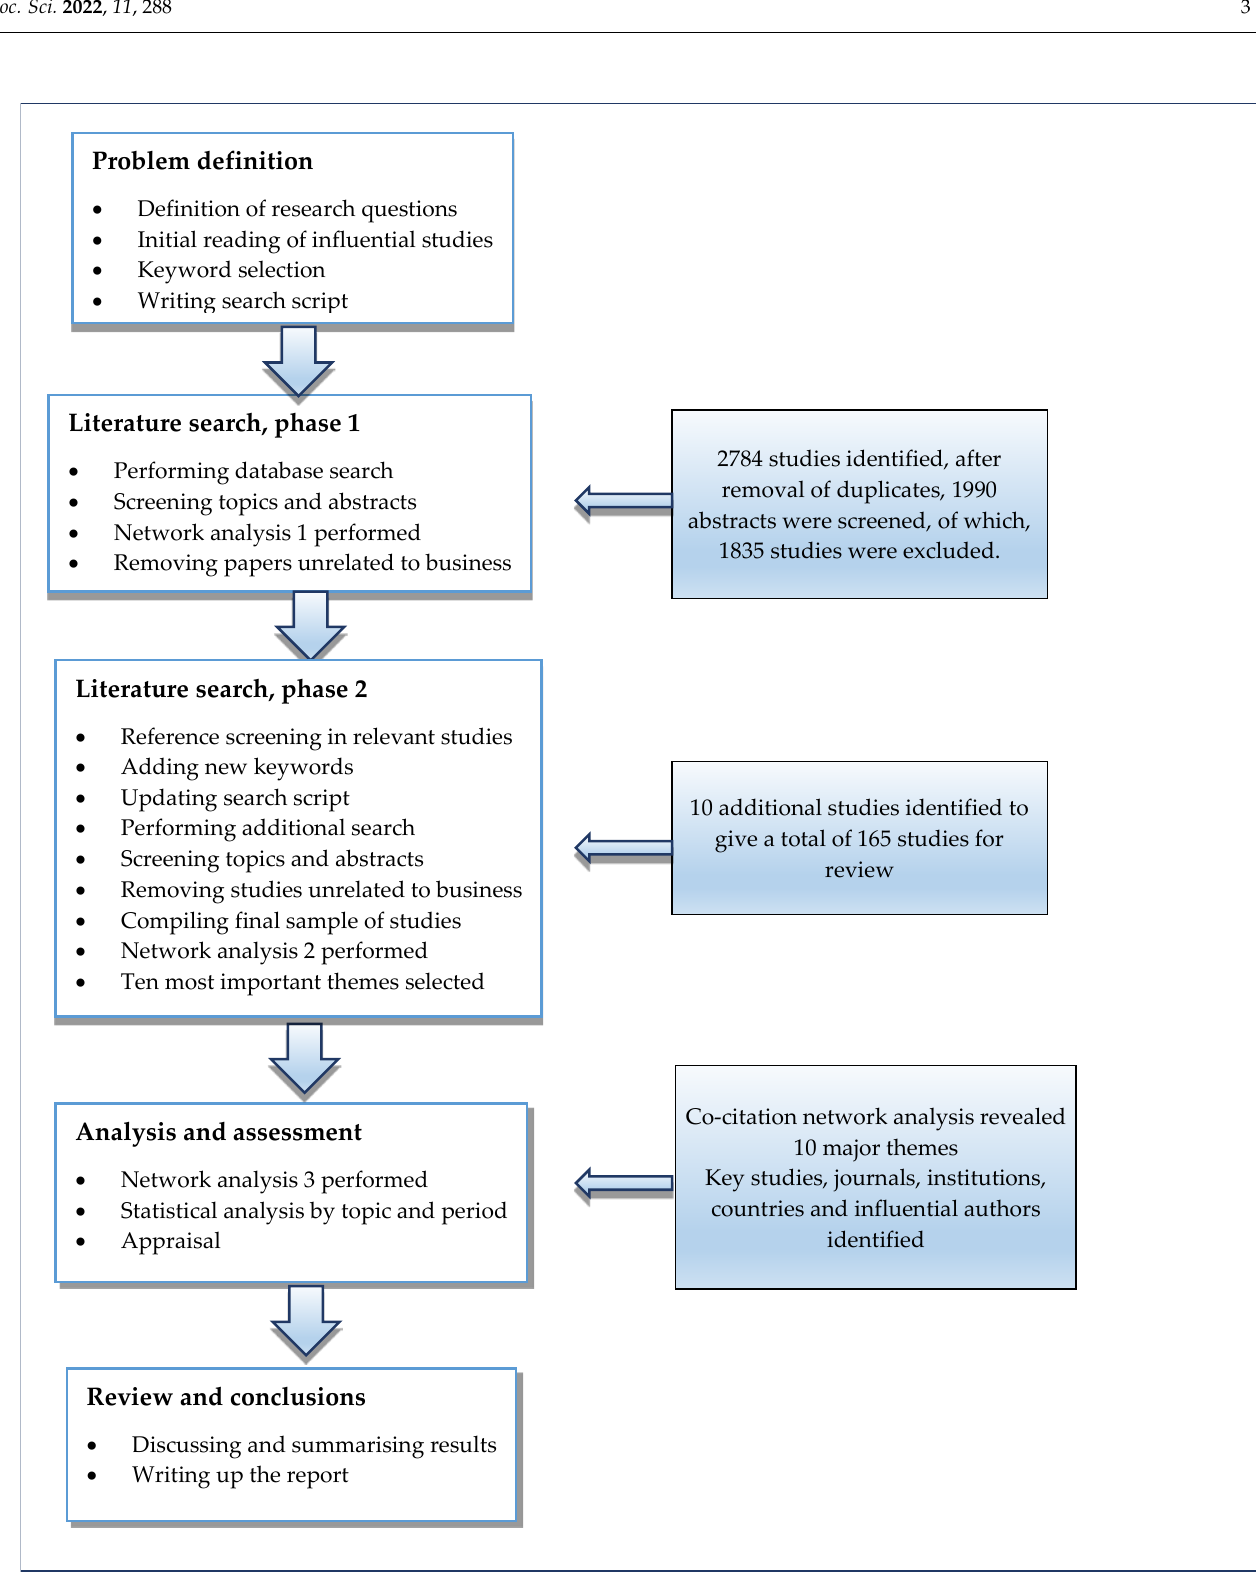
Figure 1. Flowchart for the literature review.